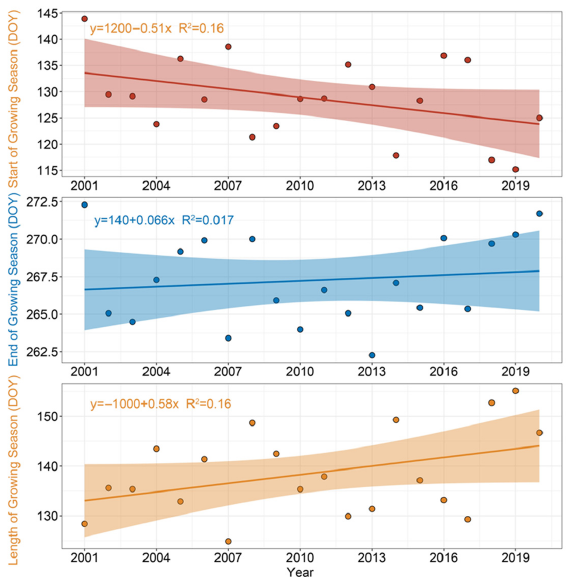
Figure 2. Interannual changes in vegetation phenology in the QLMs.